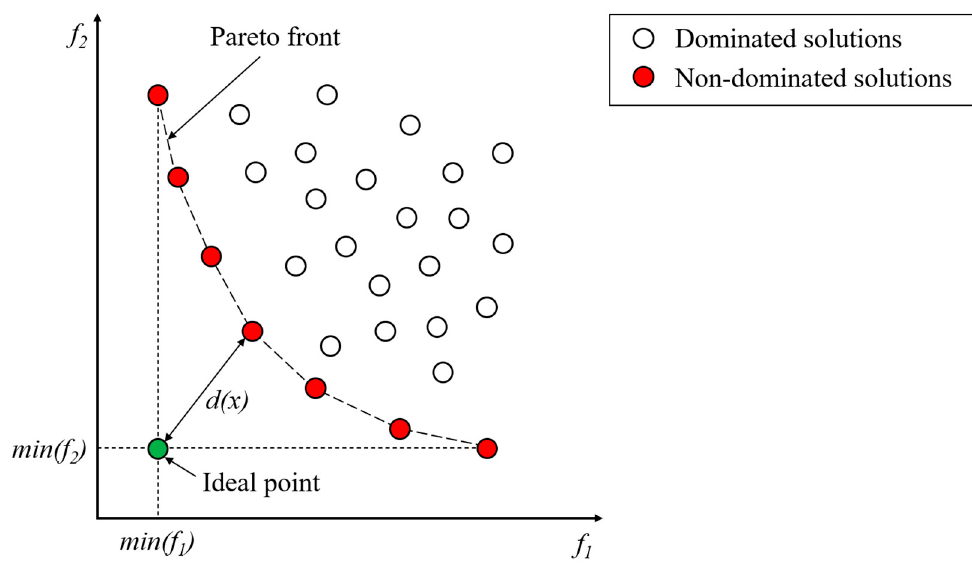
Figure 1. Pareto front for two contradictory objectives.